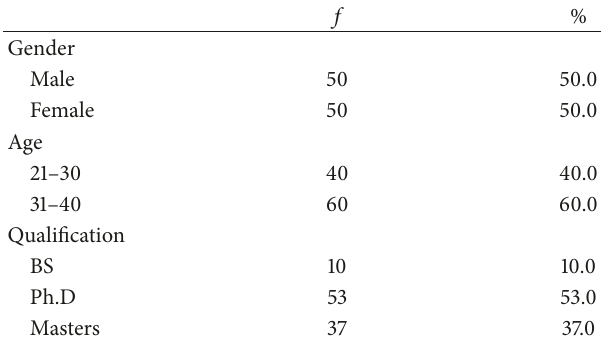
Table 1: Frequency and percentage of the sample regarding demo- graphics ( 𝑁 = 100